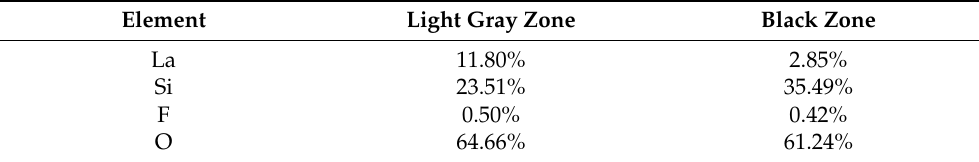
Figure 8. SEM images of Si-La after thermal treatment at 1500 ◦ C. Table 6. EDX results of Si-La after thermal treatment.